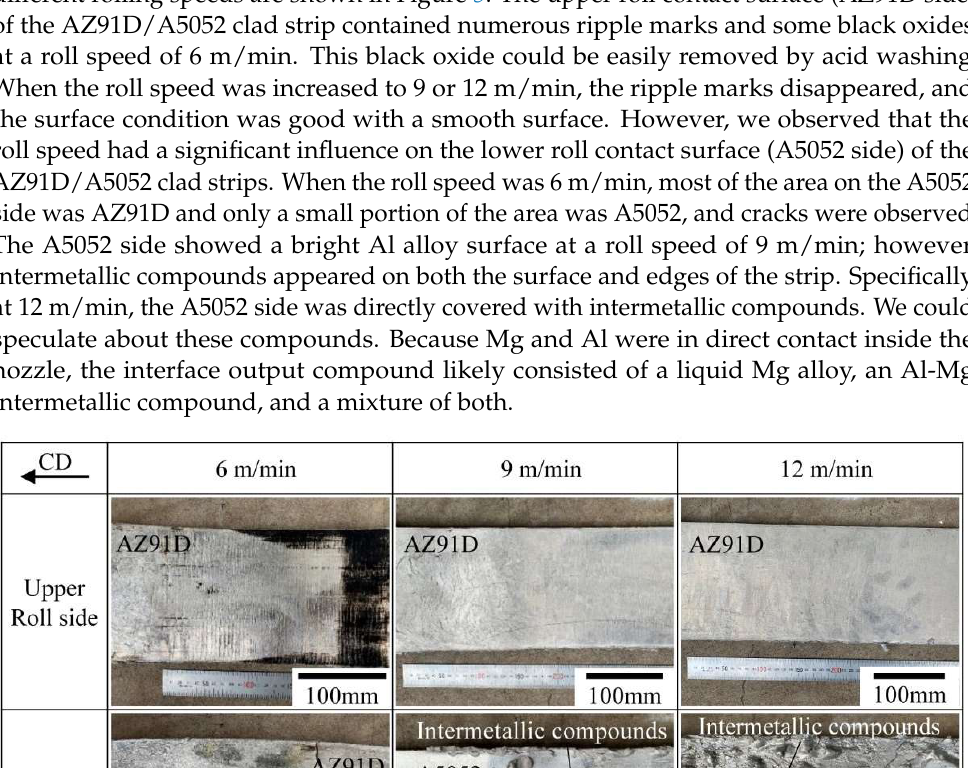
Figure 6. Schematic diagram of intermetallic compound output. Figure 7 shows the casting process at different roll speeds. At low roll speeds, there was a significant increase in the thickness of the solidification layer in both molten metals. The increased thickness of the solidification layer of the Al alloy caused the lower nozzle to become blocked and the solidified Al alloy layer could not be smoothly brought out. Thus, only a small portion of the Al alloy was bound. However, the increased thickness of the solidification layer of the Mg alloy created a downward squeezing force. This in- hibited the formation of the Al alloy in the lower nozzle, and this was consistent with the experimental results shown in Figure 5 (6 m/min). At high roll speeds, the thickness of the solidification layer in both molten metals was significantly reduced. Theoretically, with a constant roll gap, most of the intermediate gap would be filled by the molten Mg and Al alloys in a semi-solidified state. In this study, the bonding interface between the Mg alloy and Al alloy occurred at a high temperature, because the higher the temperature, the higher the energy of the atoms, the easier the migration, the higher the diffusion coeffi- cient, and the faster the diffusion. Therefore, the mutual diffusion movement of the Mg and Al atoms was very strong, which would intensify the generation of intermetallic Mg and Al compounds. The experimental single-roll casting results showed that the surface temperature of A5052 before bonding was higher than 600 °C. In addition, the AZ91D in